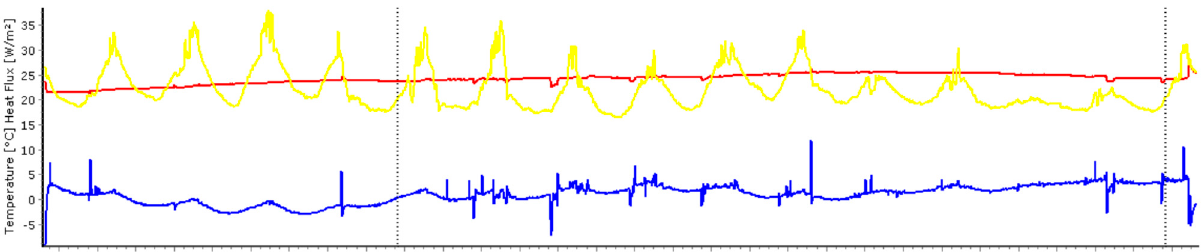
Figure 3. Temperature variation chart for the 15-day measurement period exported from the data logger (yellow line—exterior temperature, red line—interior temperature, blue line—heat flux).